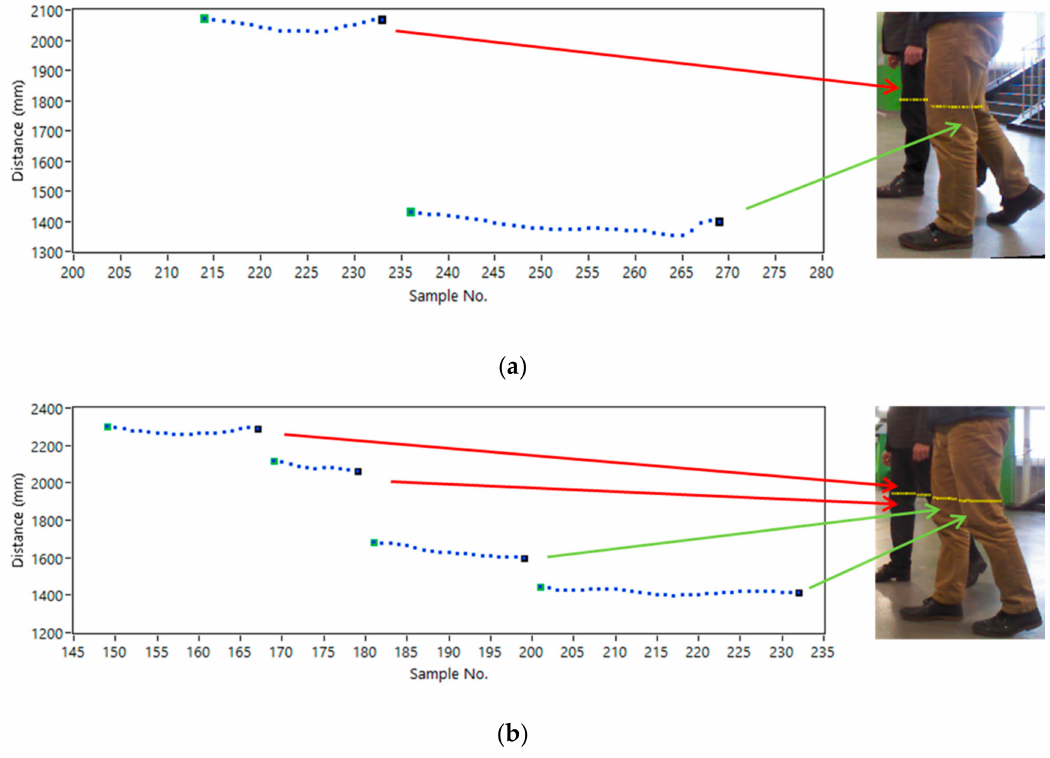
Figure 20. Raw scanner data with corresponding vision image, ( a ) first frame, ( b ) second